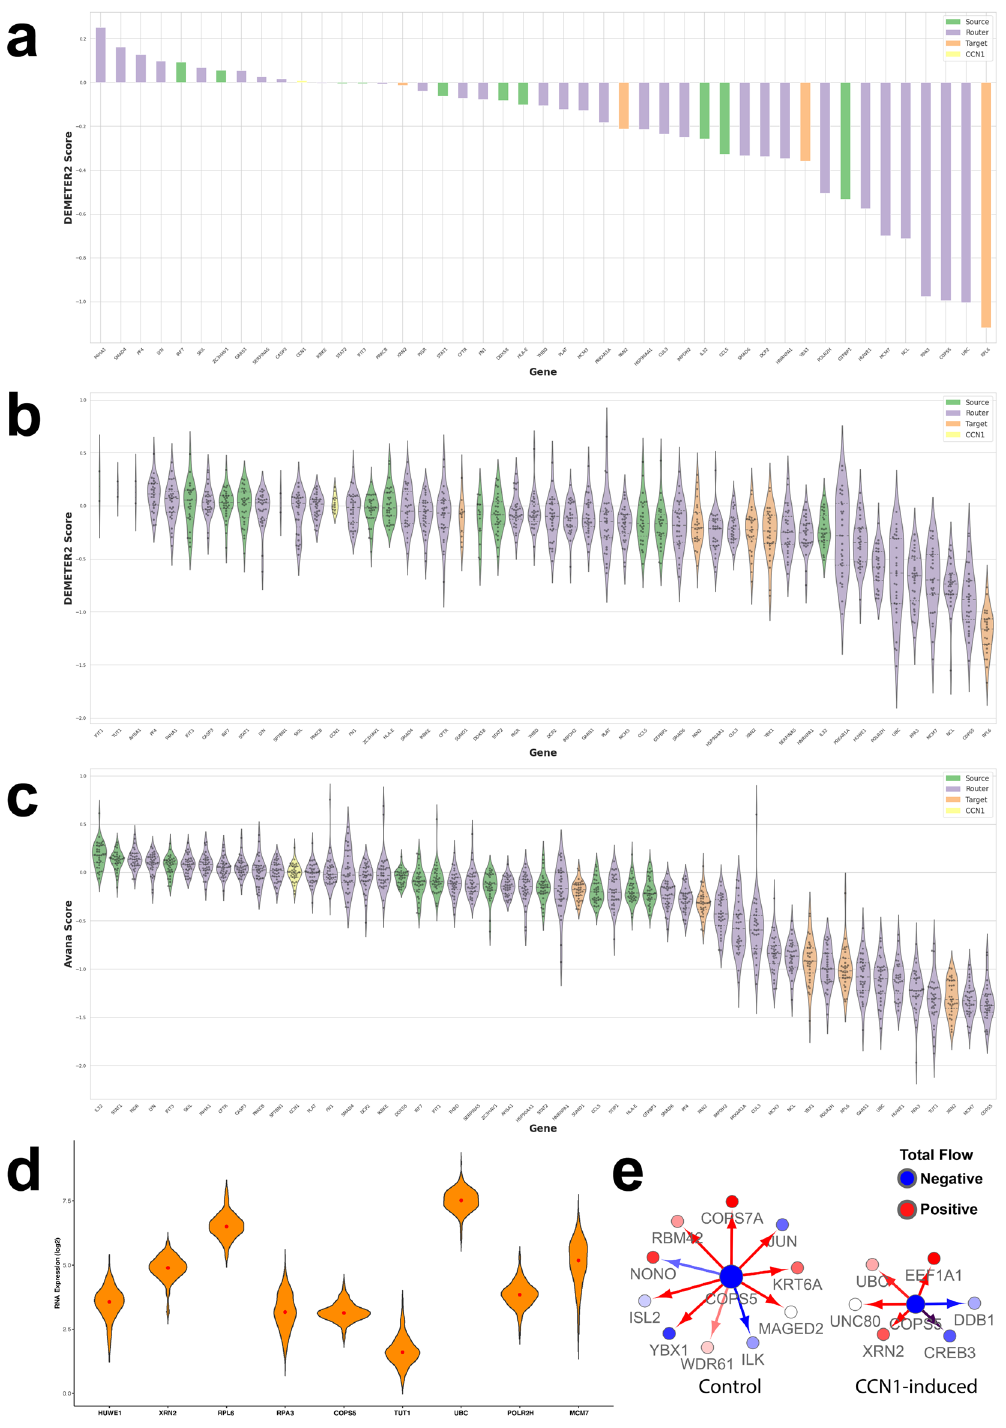
Figure 4. Gene dependencies in glioblastoma prioritized subnetwork. ( a ) Waterfall plot showing DEMETER2 scores for the LN229 human GBM cell line for genes identified in the CCN1 NetDecoder subnetwork. ( b ) Violin plot showing RNAi gene dependencies (DEMETER2 scores) for nodes in our GBM NetDecoder analysis. Depicted are GBM cell lines (range: n = 2–31). ( c ) Violin plot showing CRISPR gene dependencies (Avana scores) for nodes in our GBM NetDecoder analysis. Depicted are the GBM cell lines (range: n = 28–33). ( d ) Violin plot showing TCGA RNA expression for selected genes with low gene dependency score in GBM patients (n = 174). Colors assigned to network source, router, target genes and CCN1 are green, purple, orange, yellow, respectively. ( e ) Network router motif: COPS5. Connections decrease when CCN1 is